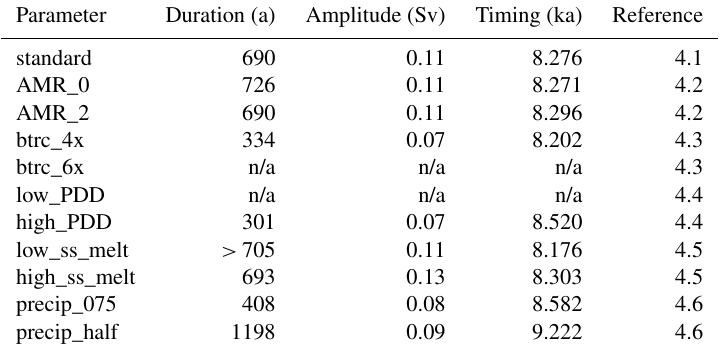
Table 2. Peak FWF duration, amplitude and timing (ka) in each simulation. The peak is defined as ongoing when the amplitude is greater than the background flux of 0.05Sv (as defined in Sect. 4.2). The “n/a” for simulations btrc_6x and low_PDD indicates that the peak of the saddle collapse does not occur prior to 8ka. The reference column indicates sections of the text discussing the specific